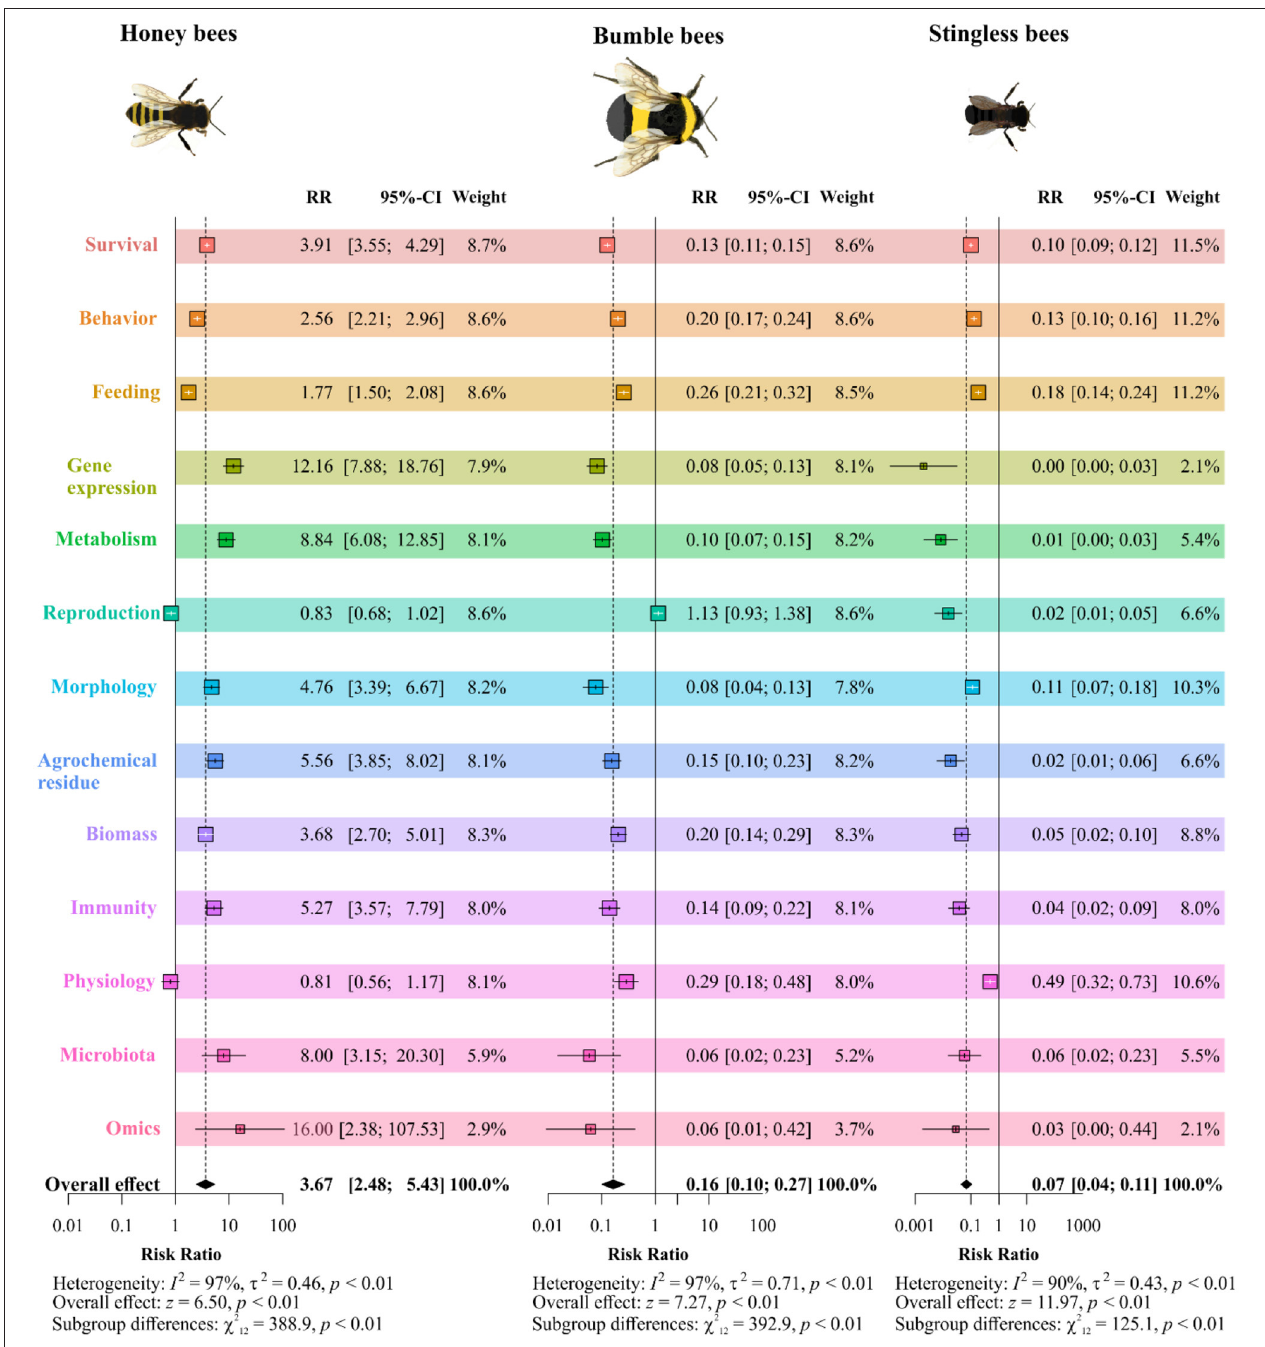
FIGURE 7 | Estimated effect sizes in the meta-analysis of the occurrence of published articles covering the type of response assessed from the main groups found in the literature review of toxicological assessment of the impact of agrochemicals on bees. The forest plots depict the estimated risk ratio (RR), 95% confidence interval (CI), and weight (inverse of the variance; larger squares indicate more precise results, i.e., small variances). The black diamond shape indicates the summary of RR ± 95% CI (overall effect for all types of responses). These estimates are based on mixed-effect model meta-analyses with inverse-variance and DerSimonian–Laird methods. RR ± 95% CI > 1 indicates a high likelihood of published articles covering the effects in some response, RR ± 95% CI < 1 indicates a low likelihood, and no bias are present when RR ± 95% CI includes 1.